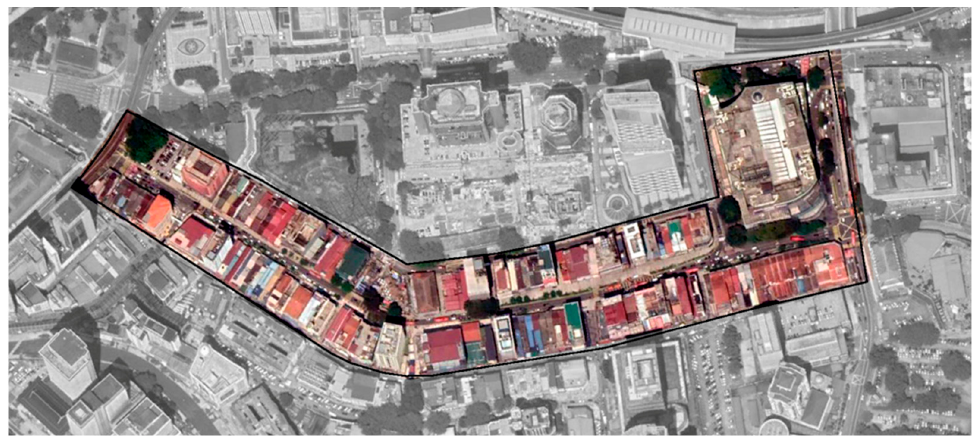
Figure 1. Location map of the study area in Kuala Lumpur (Image source: Google Earth Pro). According to Mahalingam [52], the JTAR area is well known for textile trading, and the shop lots are characterised as the “most sought-after real estate” amongst shopping districts in KL. That resulted consequently in the buildings’ facades in JTAR being scattered with different sizes of signage and billboards (Figure 2).